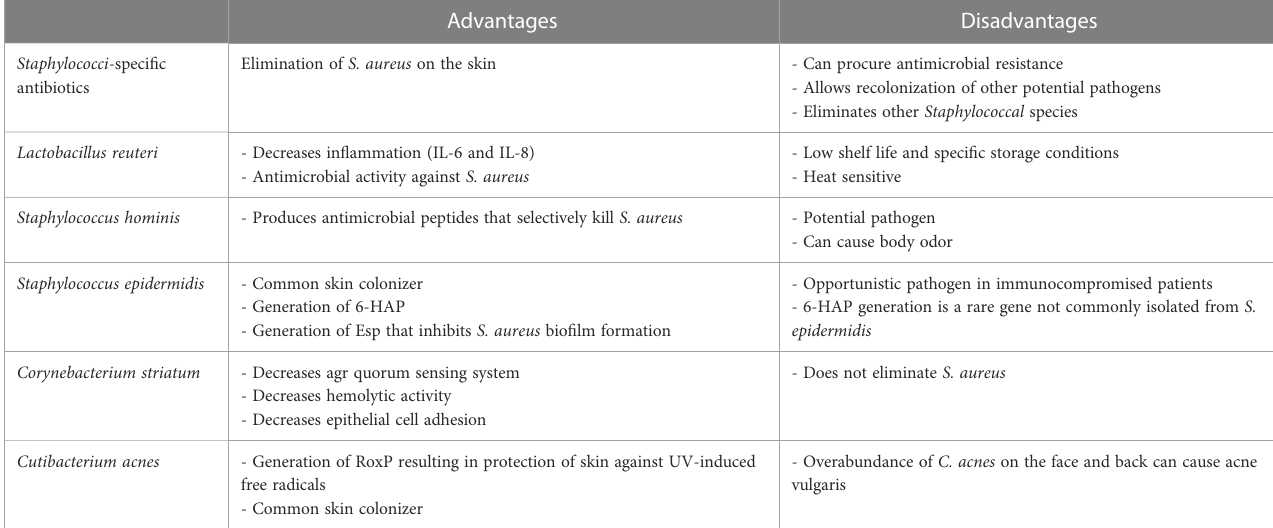
TABLE 1 Advantages and disadvantages of bacterial species for use as topical